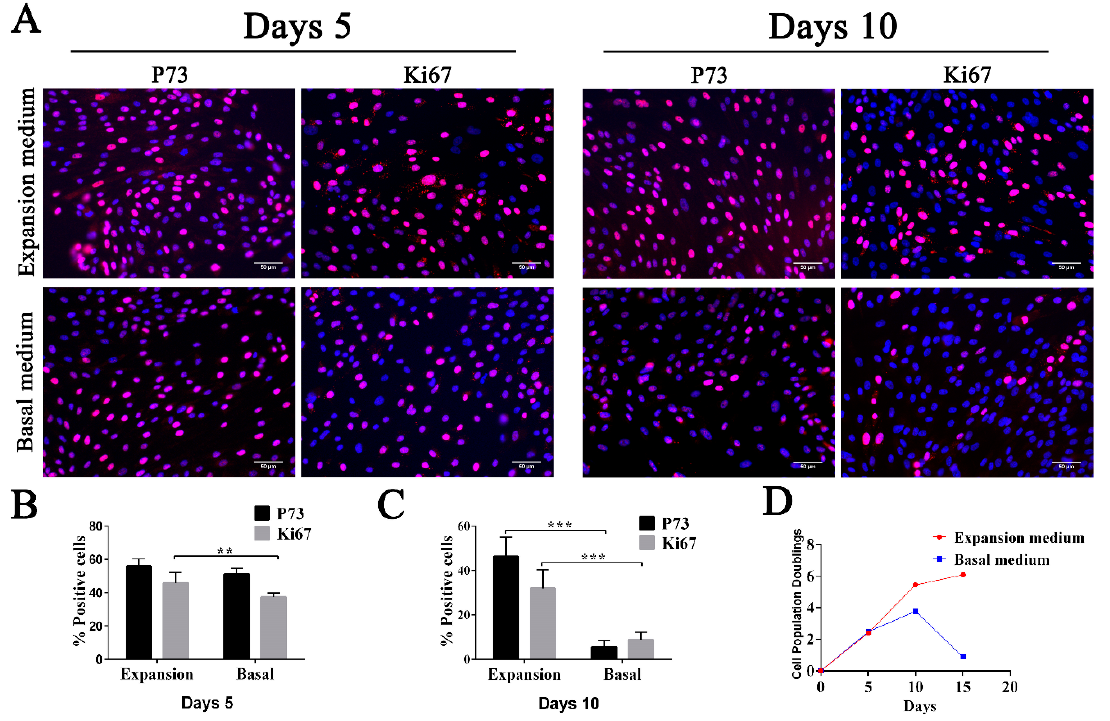
Figure 2. Characterization and proliferation rate of fallopian tube epithelium cells (FTECs) during expansion. ( A ) Primary culture of FTECs were stained by immunofluorescence with a marker for actively dividing cells (Ki67, red), a basal cell marker (p73, red), and DAPI (blue) 5 and 10 days after incubation in expansion or basal medium. Scale bars: 50 µm. ( B , C ) Quantitation of Ki67- and p73-positive cells at 5 days and 10 days of culture (analysis of variance (ANOVA) test, n = 7). ( D ) Doubling of population of primary cultured FTECs grown in expansion or basal medium over time. ** p < 0.01, and *** p < 0.001.